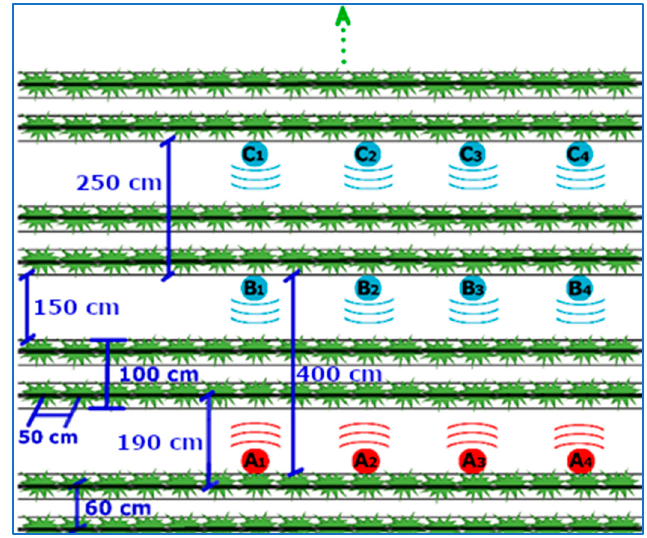
Figure 2. Top view of the deployment of the Tx and Rx nodes inside the greenhouse.